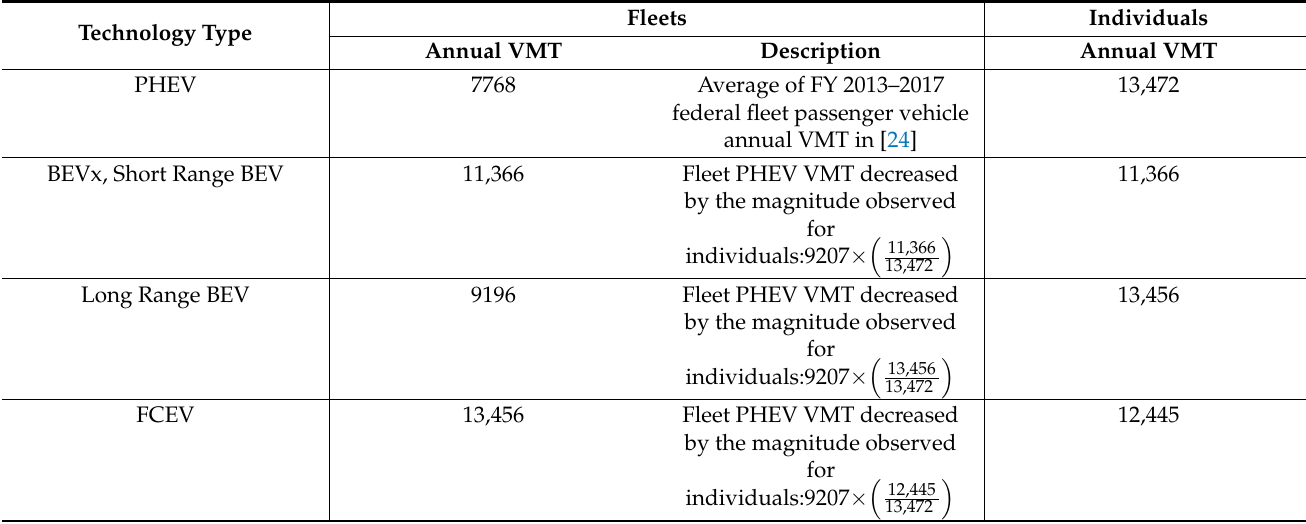
Table A2. Description of Annual VMT Calculations for